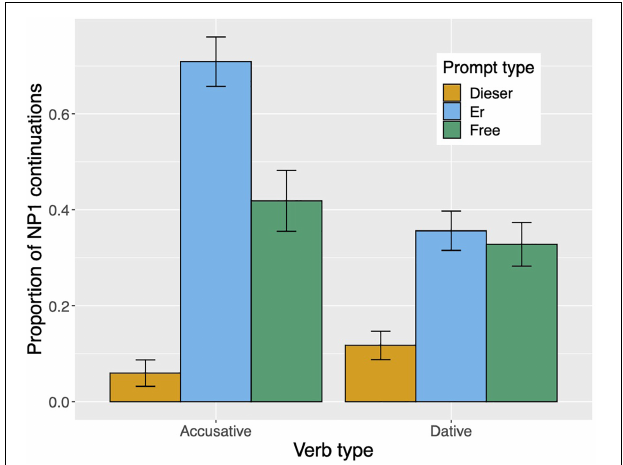
FIGURE 1 | Proportion of NP1 continuations per prompt condition ( er, dieser, and free ) and verb type in Experiment 1. The NP1 continuations represent the